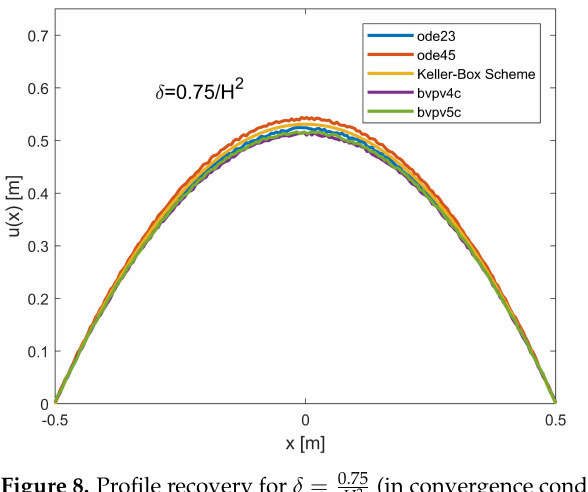
Figure 8. Profile recovery for δ = 0.75